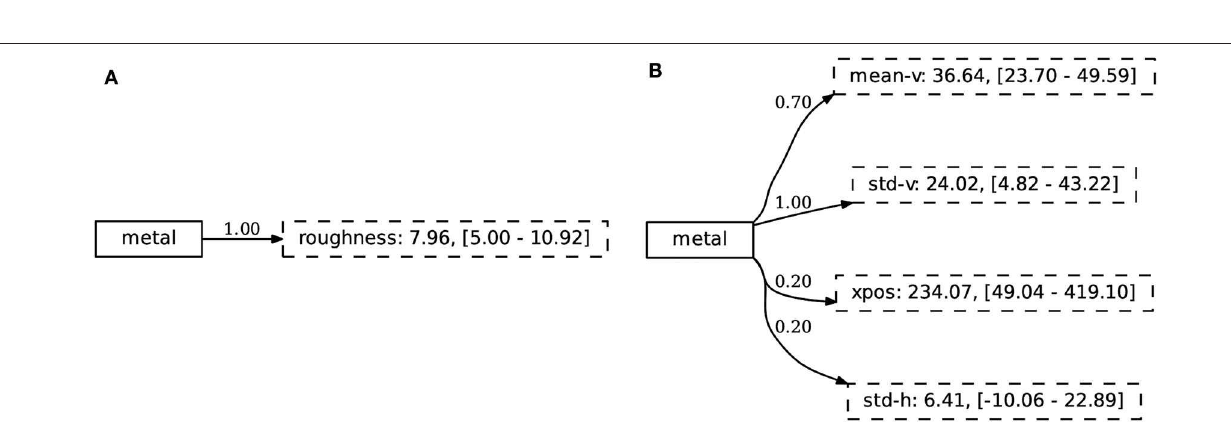
Frontiers in Robotics and AI |